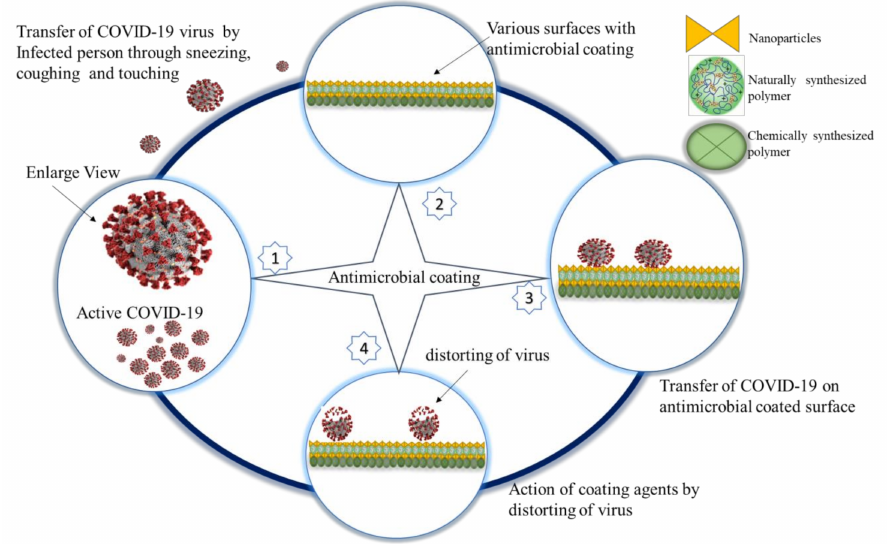
Figure 7. Schematic display of functioning of antimicrobial material on COVID-19